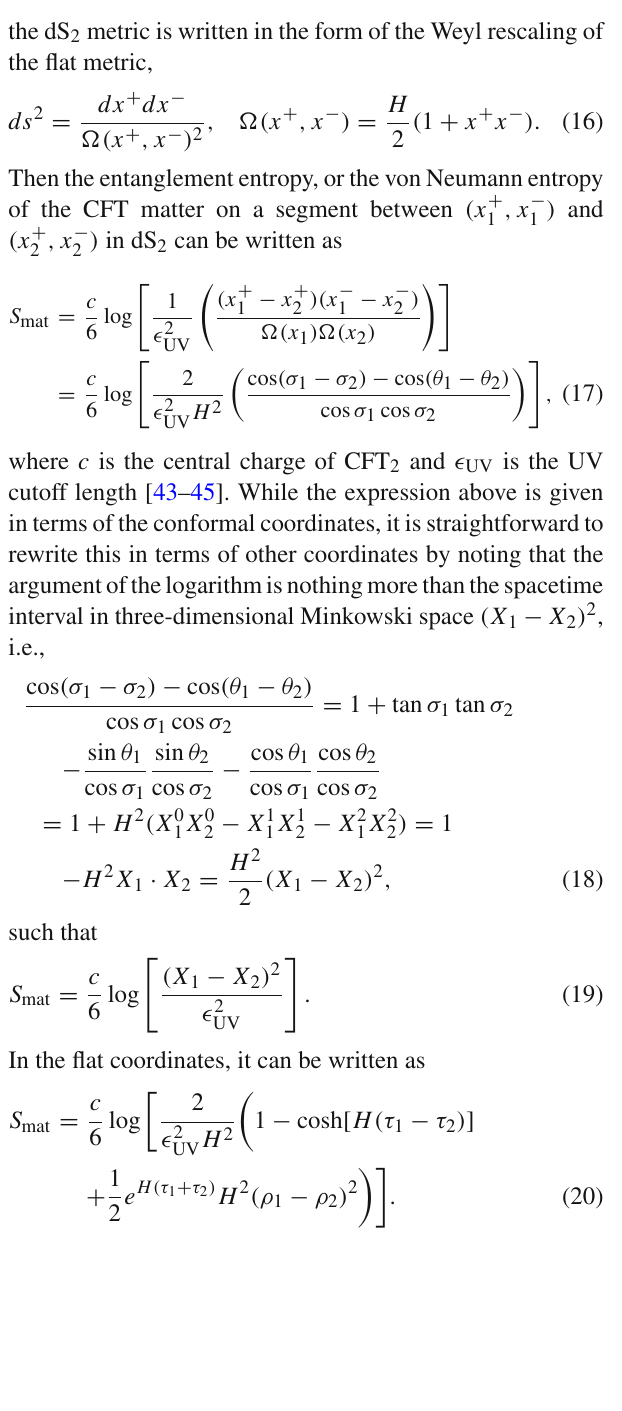
Fig. 2 (Left): Covering of regions I (static patch) and II by their own static coordinates. Here t ( r ) is constant on grey dashed (grey) lines. (Right): Covering of the inflating patch, the union of regions I and II by the flat coordinates. Here τ ( ρ ) is constant on grey dashed (grey) lines